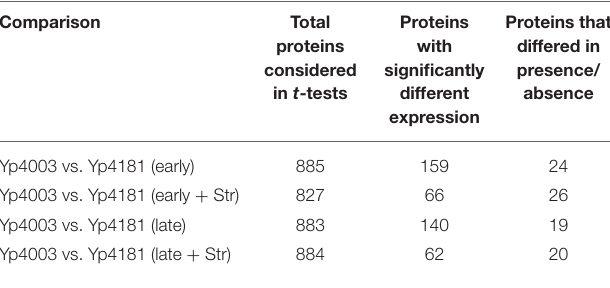
Proteins proteins with considered significantly in t -tests different